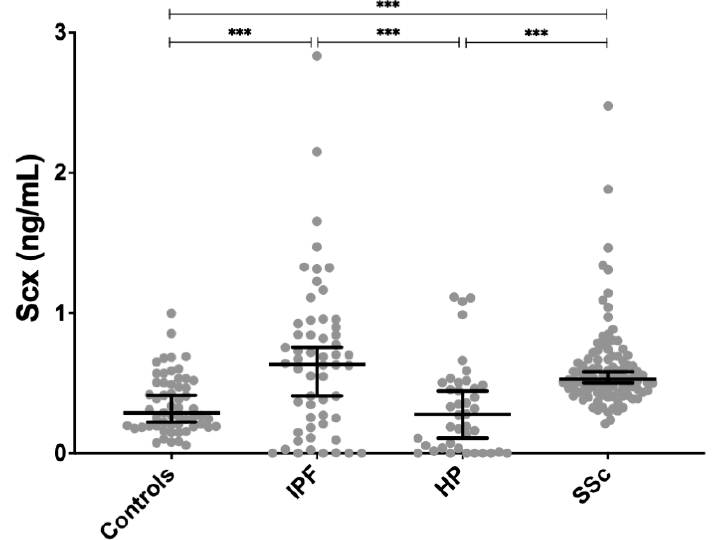
Figure 4. SCX serum concentrations were significantly higher in patients with IPF and SSc compared to controls. SCX serum levels in patients with HP were not different from controls but differed significantly from patients with IPF and SSc. *** = p < 0.001.